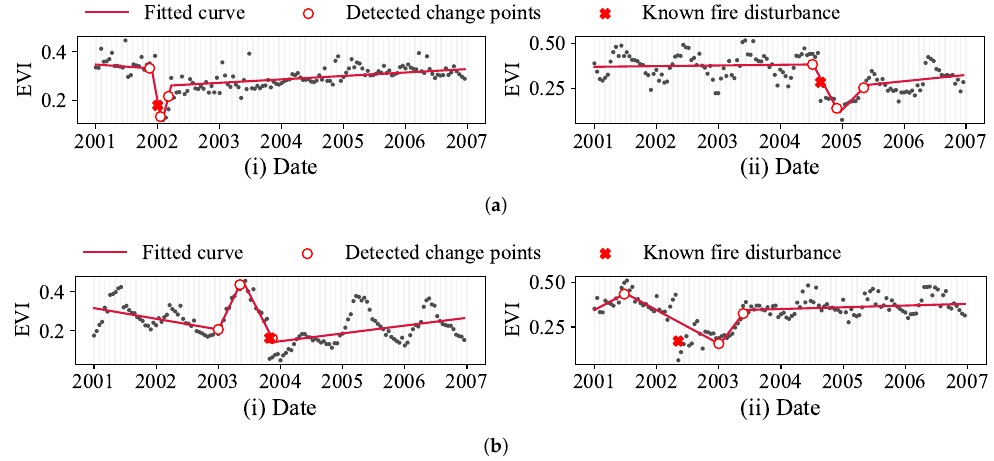
Figure 7. Partial detection results by LandTrendR model. ( a ) The detection advantages of the LandTrendR model: ( i ) and ( ii ) the model can effectively detect time series with obvious changing trends. ( b ) The detection limitations of the LandTrendR model: ( i ) the model cannot decompose the periodic component, resulting in the model likely to detect intra-annual seasonal variation; ( ii ) the model only focuses on global changes and cannot detect subtle change